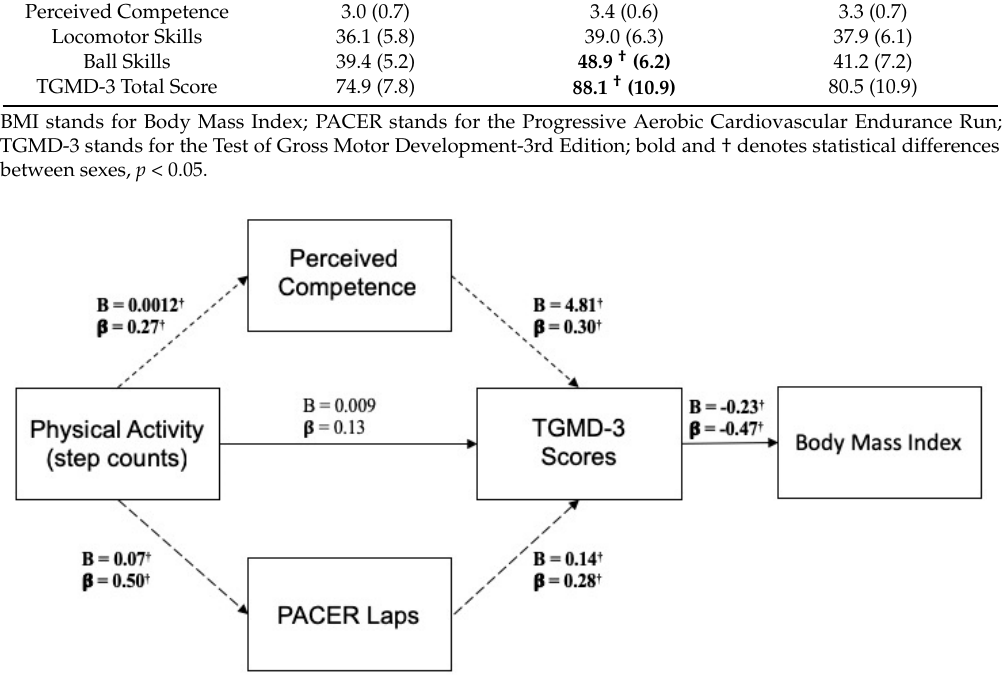
Figure 1. Path diagram aligning with the motor competence and health-related variable conceptual framework. Note : PACER stands for the Progressive Aerobic Cardiovascular Endurance Run; TGMD-3 stands for the Test of Gross Motor Development-3rd Edition; B denotes unstandardized coefficients; β denotes standardized coefficients; dashed lines represent a mediated (indirect) relationship; bold lines represent a non-mediated (direct) relationship; bold and † denotes statistical significance, p < 0.05. Table 2. Equation-level goodness-of-fit-statistics.